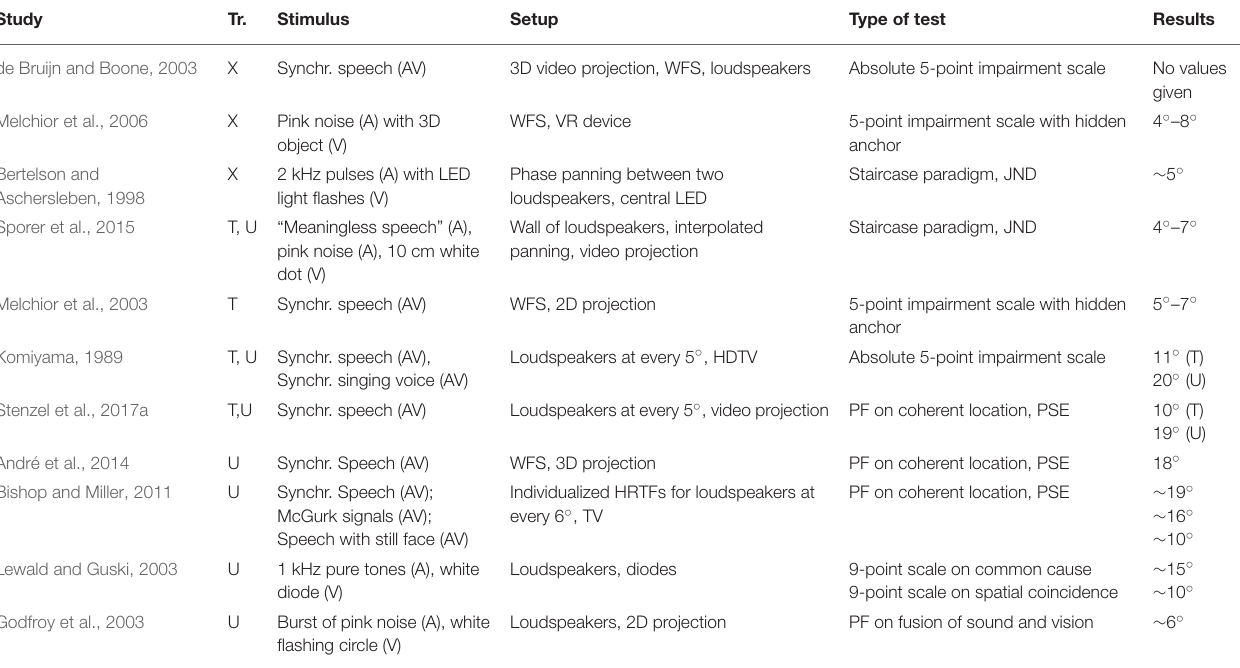
TABLE 1 | Summary of papers on the limit of ventriloquism in audio-visual application settings. Study